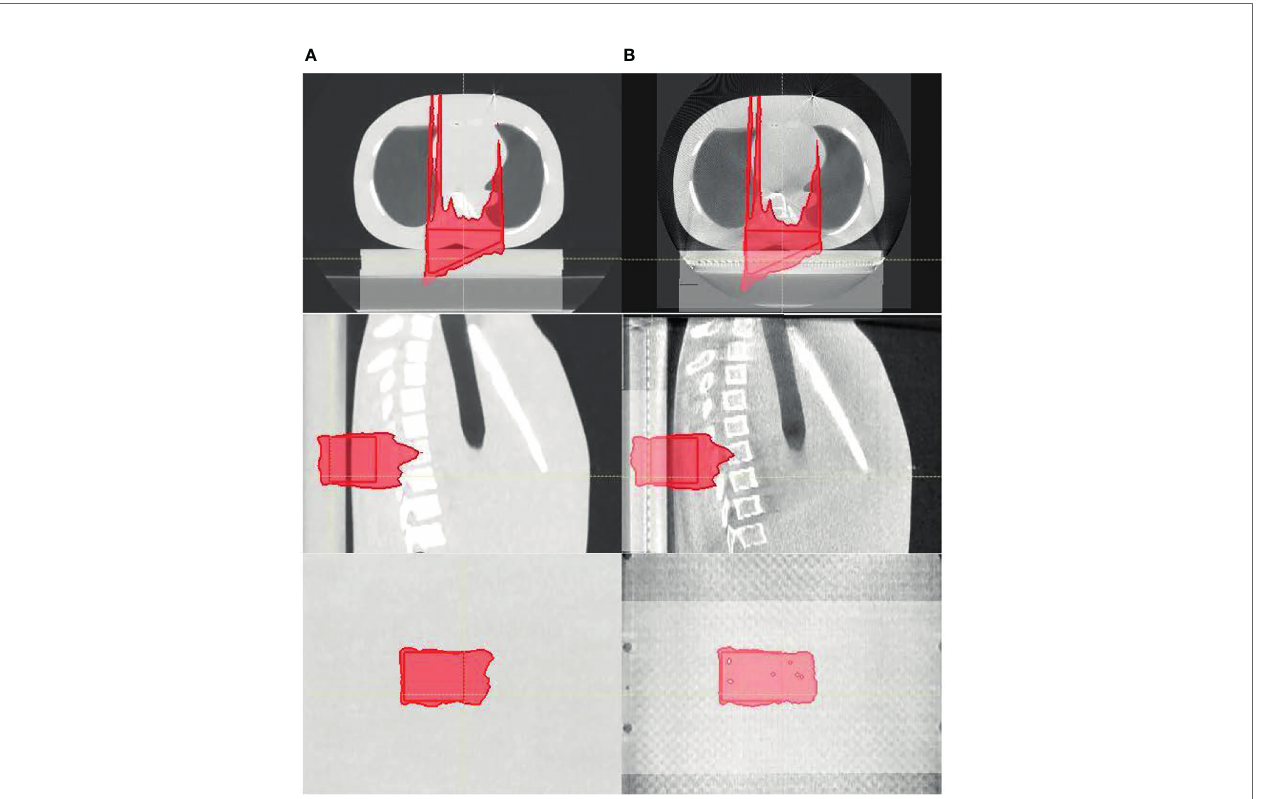
FIGURE 7 | The proton dose distribution calculated on (A) planning CT and (B) cone-beam CT (CBCT) for the thorax phantom.